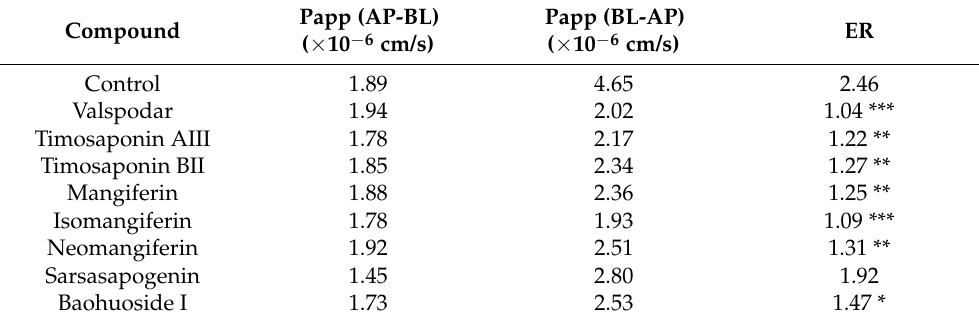
Table 3. The efflux ratio and Papp of rhodamine-123 in combination with seven constituents of AR and valspodar (n =